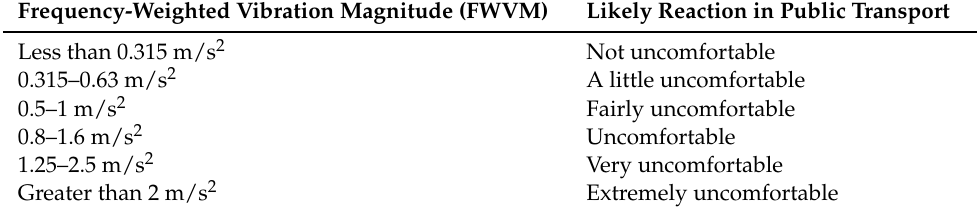
Table 3. ISO 2631-1:1997, magnitudes of overall vibration [25].